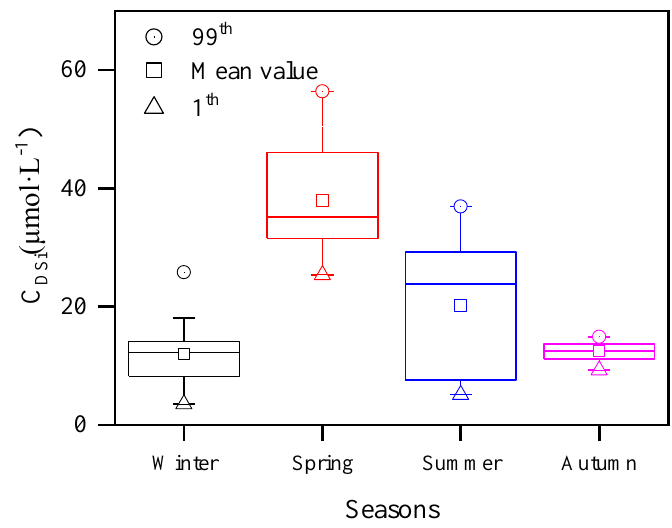
Figure 3. Seasonal changes in DSi illustrated using a box diagram for the coastal water of Zhanjiang